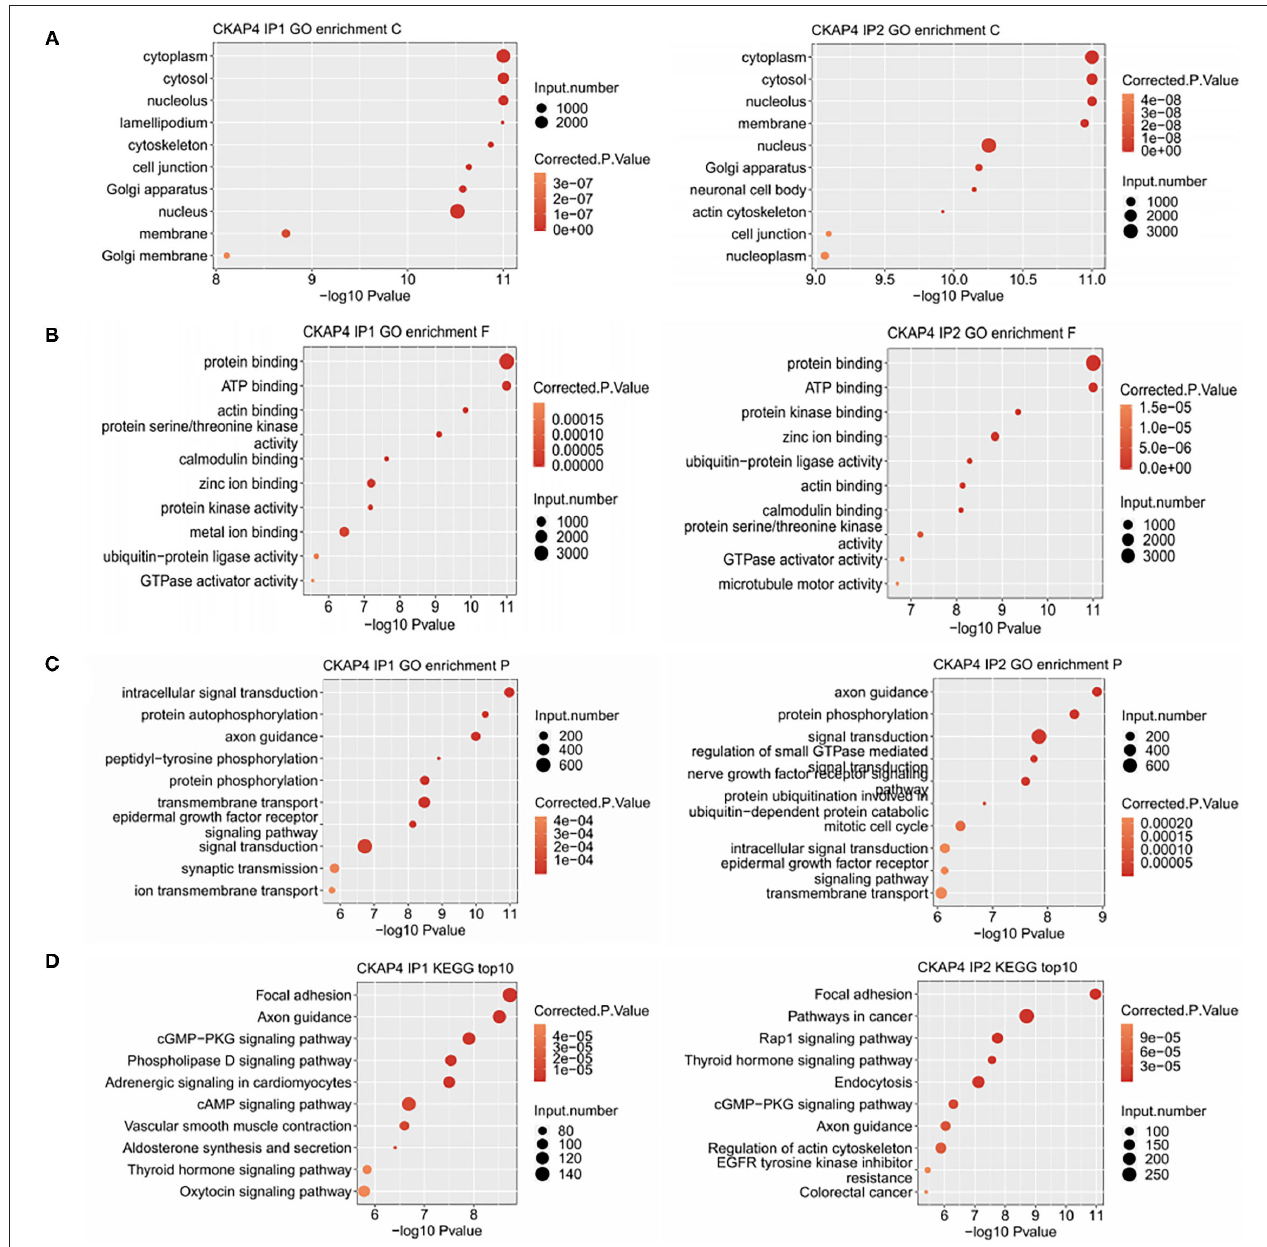
FIGURE 2 | Binding peak-related gene cluster enrichment analysis. Bubble plot showed the top 10 enriched GO cellular component (A) , molecular function (B) , biological process (C) and KEGG (D) categories for the CKAP4-bound